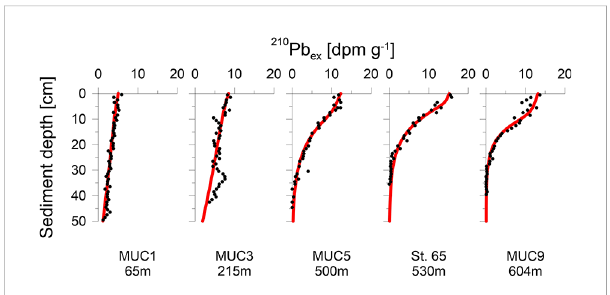
FIGURE 2 Measured data (symbols) and model simulations (curves) of 210 Pb ex